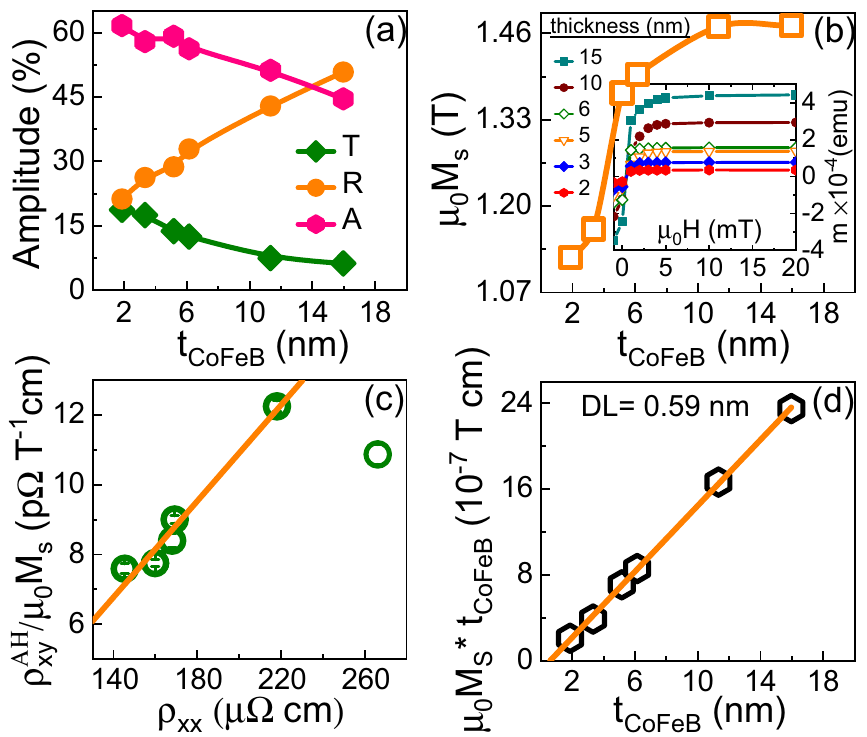
Figure 5. ( a ) Transmission ( T ), reflectance ( R ) and absorption ( A ) vs. t CoFeB . Solid lines are shown as guide to the eye. ( b ) Saturation magnetization µ 0 M s vs. t CoFeB . Solid line is shown as guide to the eye. ( c ) ρ AH xy /µ 0 M s vs. ρ xx . Solid line is a linear fit excluding the result for the 2 nm thick film. ( d ) µ 0 M s · t CoFeB vs. t CoFeB . Solid line is a linear fit to the experimental